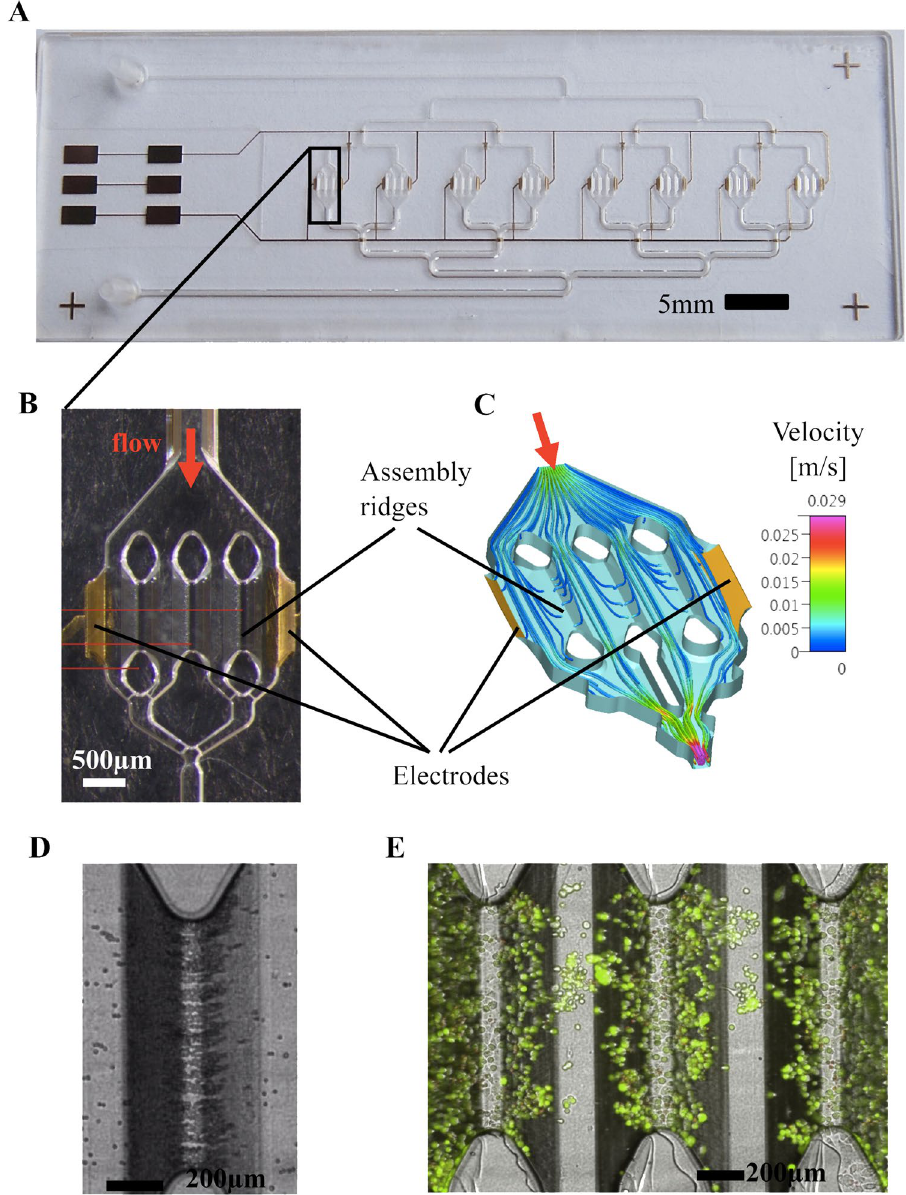
Figure 3. HepaChip: (A) Full view of the chip with 8 culture chambers, fluidic inlet and outlet and gold electrodes. (B) close up of one chamber containing 2 electrodes and 3 assembly ridges coated with collagen. (C) Simulation of flow velocity and trajectories of cells during DEP assembly inside a culture chamber. (D) PANC1 cells assembled on one assembly ridge right after assembly. (E) Live/Dead staining of PANC1 cells after 146 hours of perfused culture inside the HepaChip ®